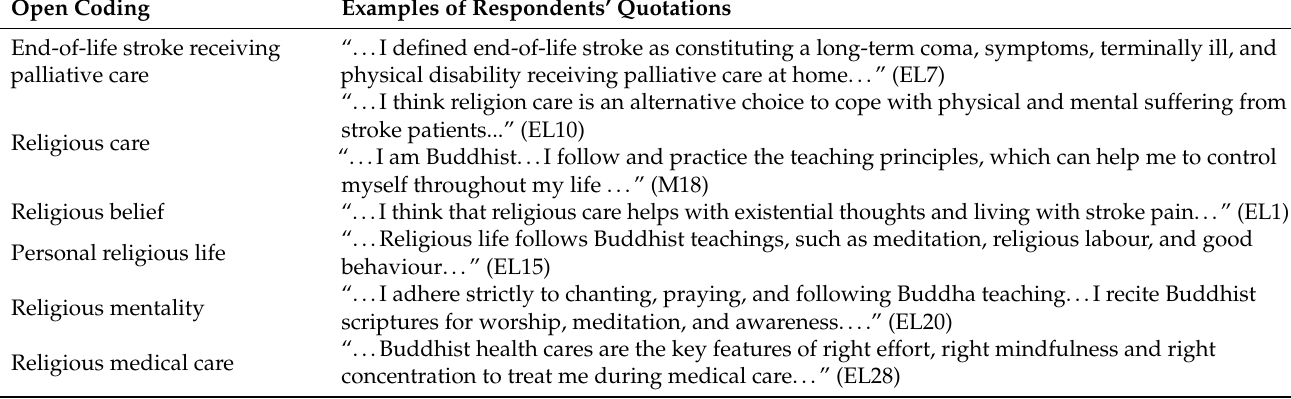
Table A1. An example of open coding.